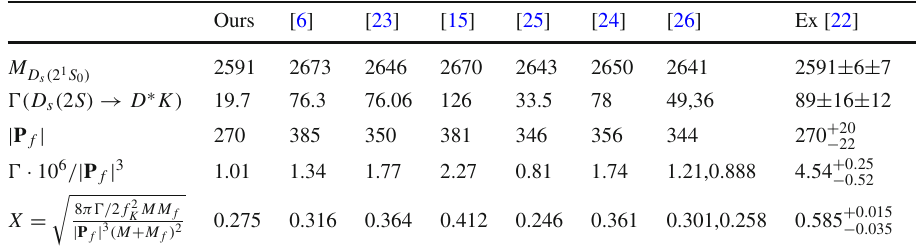
Table 3 Mass, strong decay width of D s ( 2 1 S 0 ) , recoil momentum | P f | (MeV), the ratio (cid:3)/ | P f | 3 (MeV − 2 ) and the model independent quantity